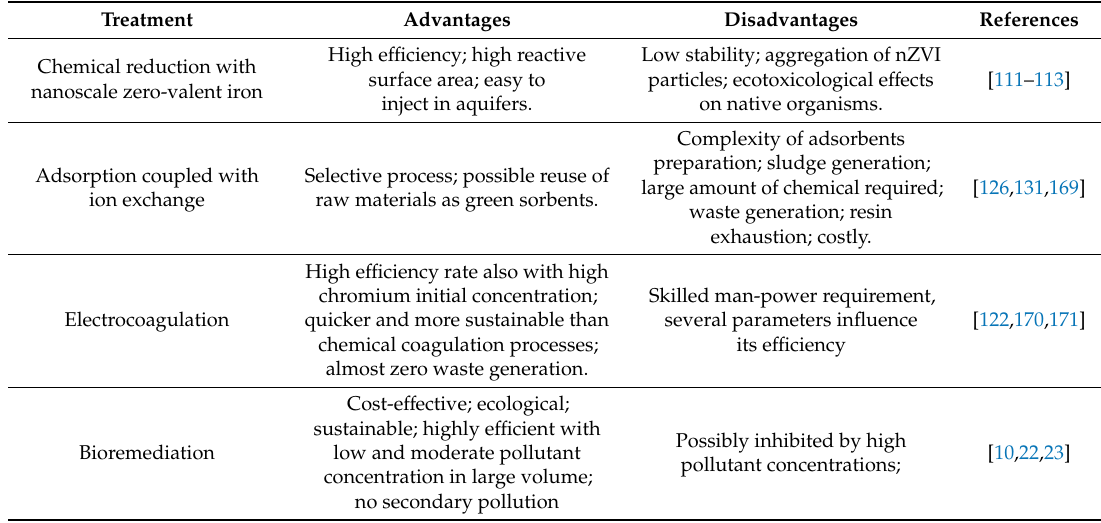
Table 4. Summary of the main advantages and disadvantages of common chemical and biological treatments for Cr (VI) removal. nZVI, nanoscale zero-valent iron.